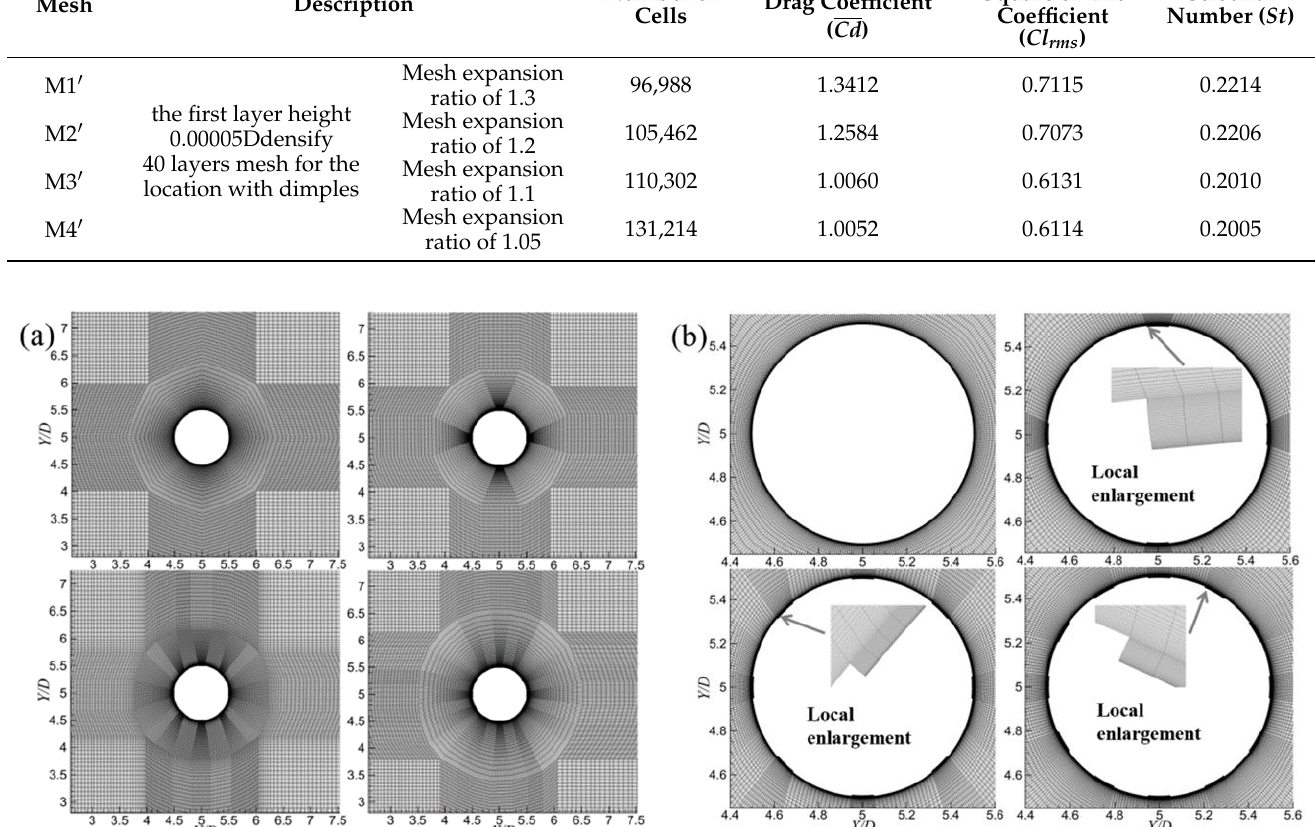
Figure 2. Schematic diagrams of the mesh: ( a ) Computational grid; ( b ) Close-up of the grid around the cylinder.